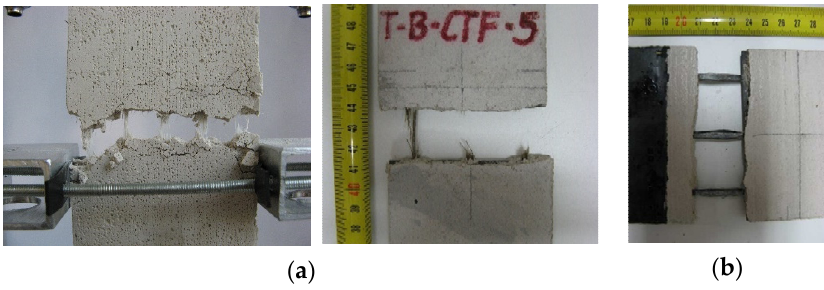
Figure 11. Failure modes observed in the tests: ( a ) fabric rupture—Mode B (specimens A-G-6 and B-CTF-5); ( b ) fabric slippage—Mode C (specimen C-CTF-2). B-CTF-5); ( b ) fabric slippage—Mode C (specimen